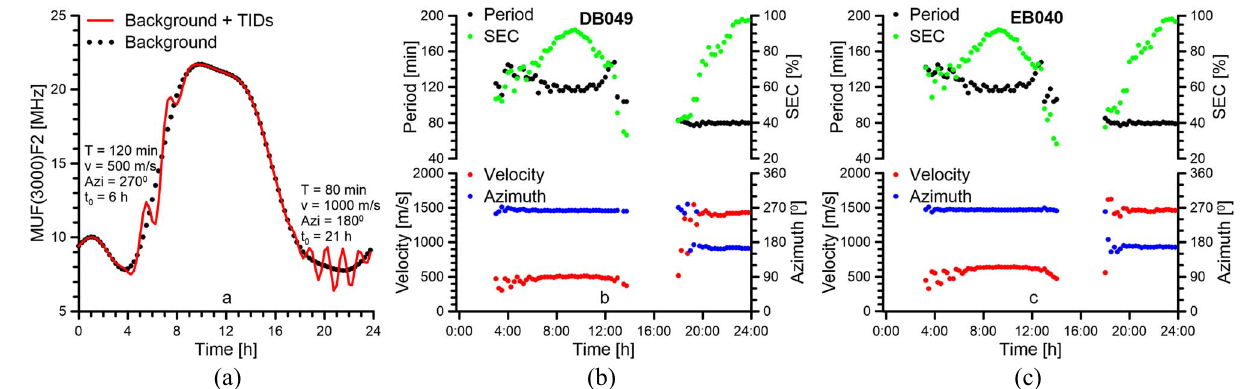
Fig. 2. Veri fi cation of the HF-Int method with synthetic data. (a) Simulated time variations of the MUF(3000)F2 for EB040 on 15 January 2017, with two TIDs events generated analytically according to equation (6) (red line) with the indicated characteristics. Black dots correspond to the background calculated by IRI. (b) and (c) Results of the HF-Int method for DB049 and EB040